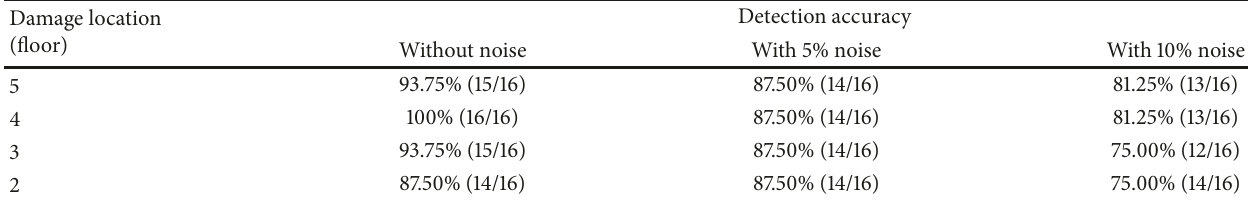
Table 4: Detection accuracy of identified damage locations based on WPEV and